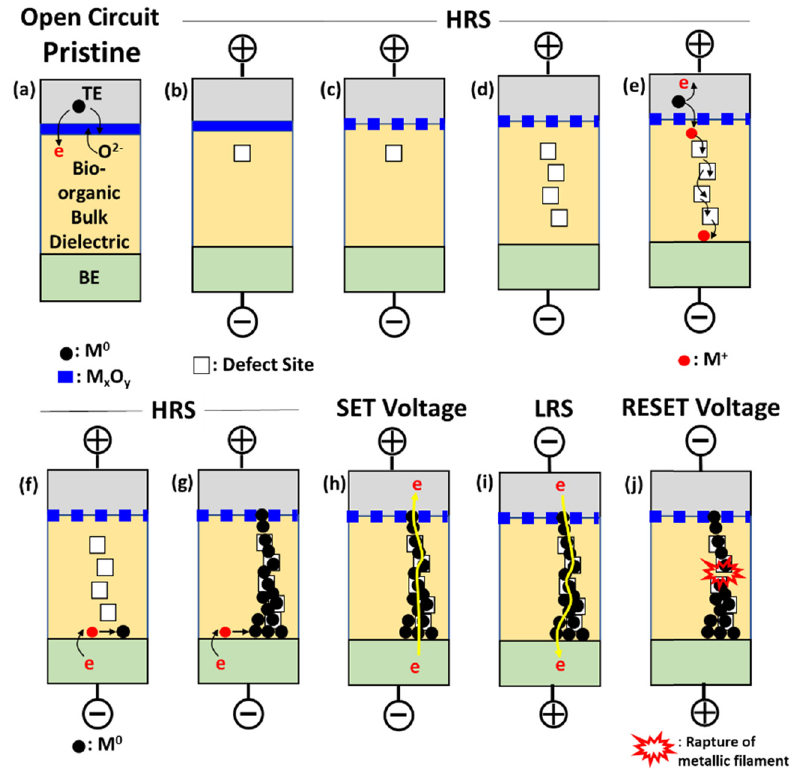
Figure 13: A series of schematics illustrating electrochemical processes of resistive switching for a typical bio - organic bulk dielectric sandwiched between a top electrode ( TE ) and a bottom electrode ( BE ) when it is subjected to DC voltage sweeps. This fi gure is modi fi ed from ref. [ 18 ]